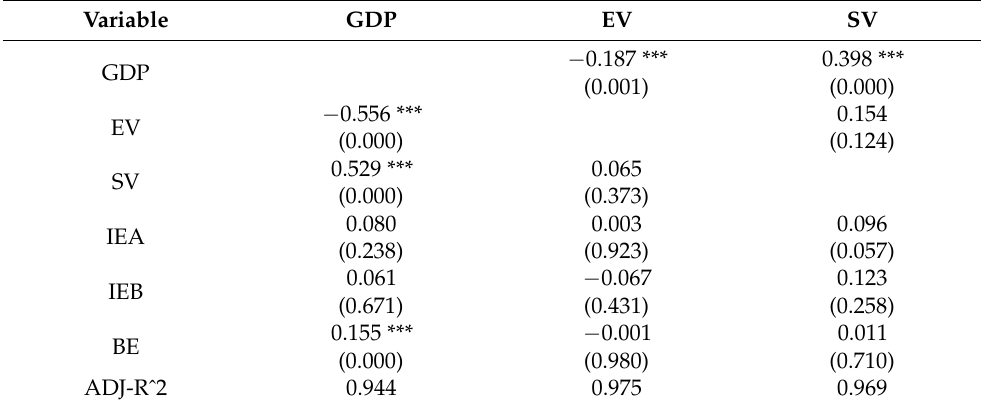
Table 5. FMOLS estimation